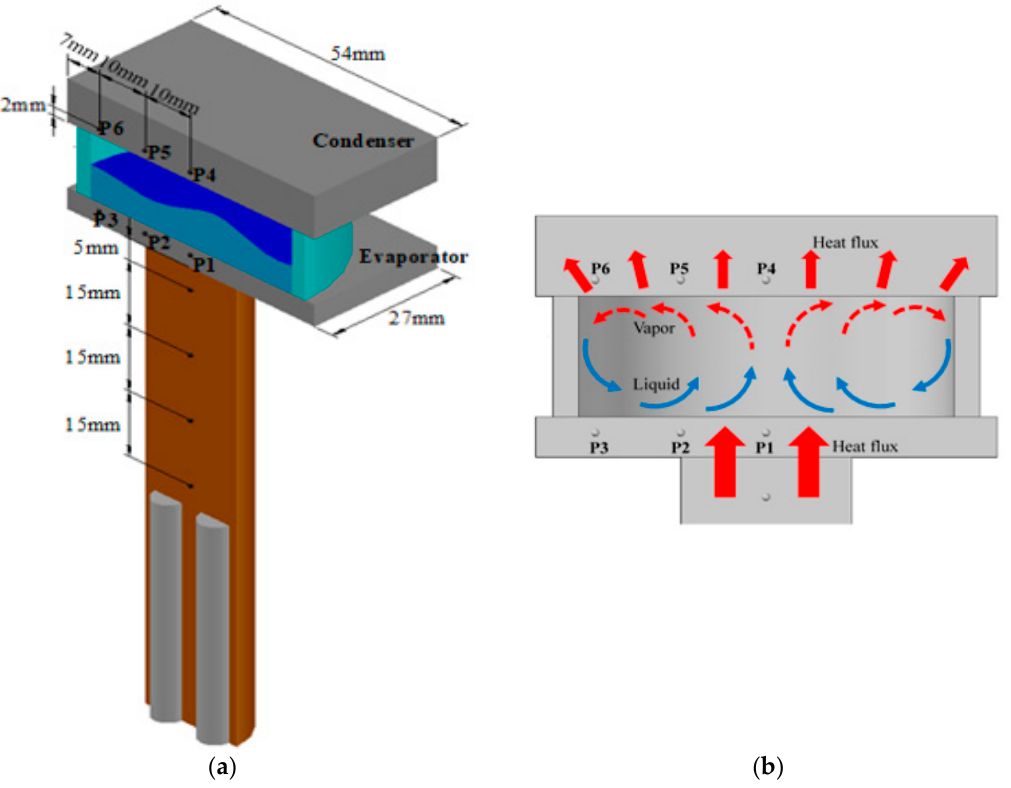
Figure 3. Schematic of temperature measuring points: ( a ) thermocouple positions; ( b ) diagram of temperature measuring in the two-phase thermosyphon.